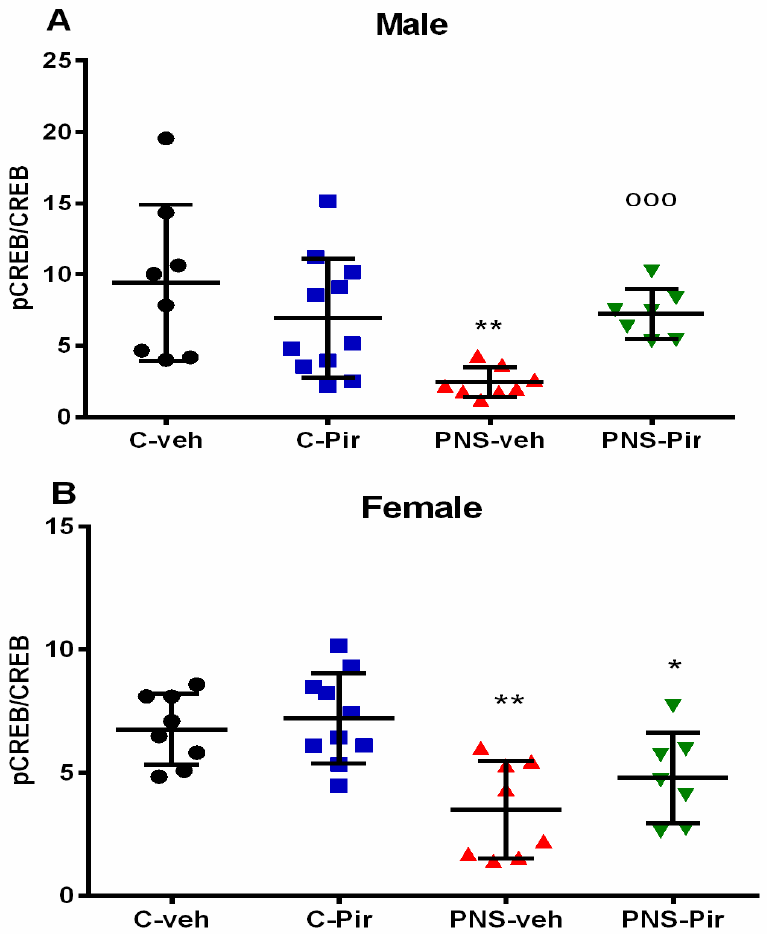
Figure 3. The chronic Piromelatine treatment exerted a sex-dependent elevation of pCREB/CREB ratio in the hippocampus in a PNS model. Three-way ANOVA indicated a main PNS effect [F 1,54 = 14.482, p < 0.001], PNS × drug interaction [F 1,54 = 6.943, p = 0.011], and interaction between PNS × sex × drug [F 1,54 = 4.364, p = 0.041] in ( A ) male and ( B ) female offspring. Data are presented as means ± SEM: * p < 0.005 vs. C-veh, o p < 0.005 vs. PNS-veh, # p < 0.05 vs. male.